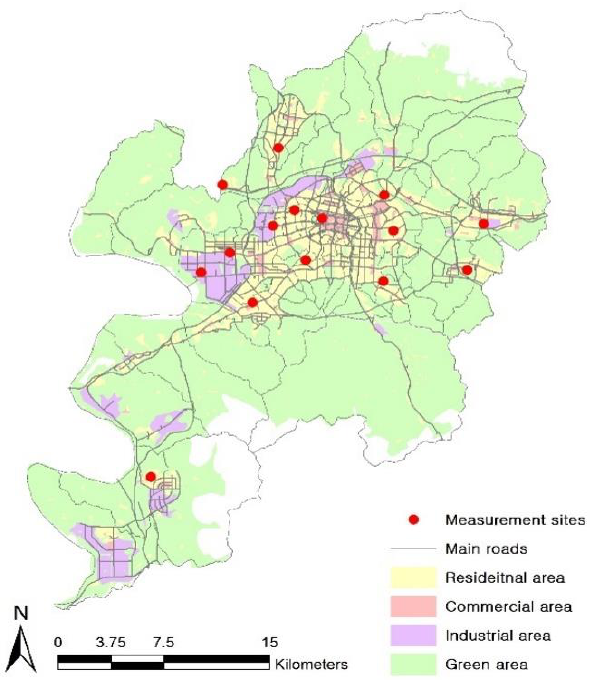
Figure 1. Air-monitoring stations in Daegu.